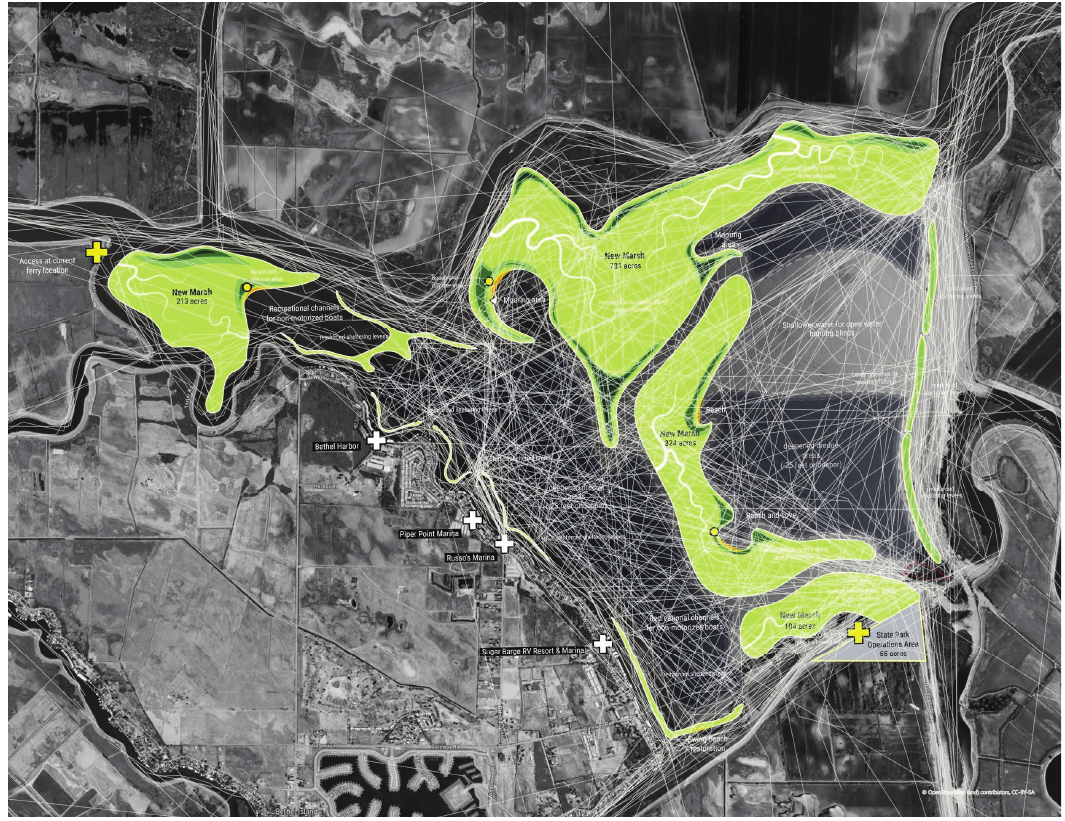
Figure 13. Boating route survey responses (white lines) superimposed on the preferred